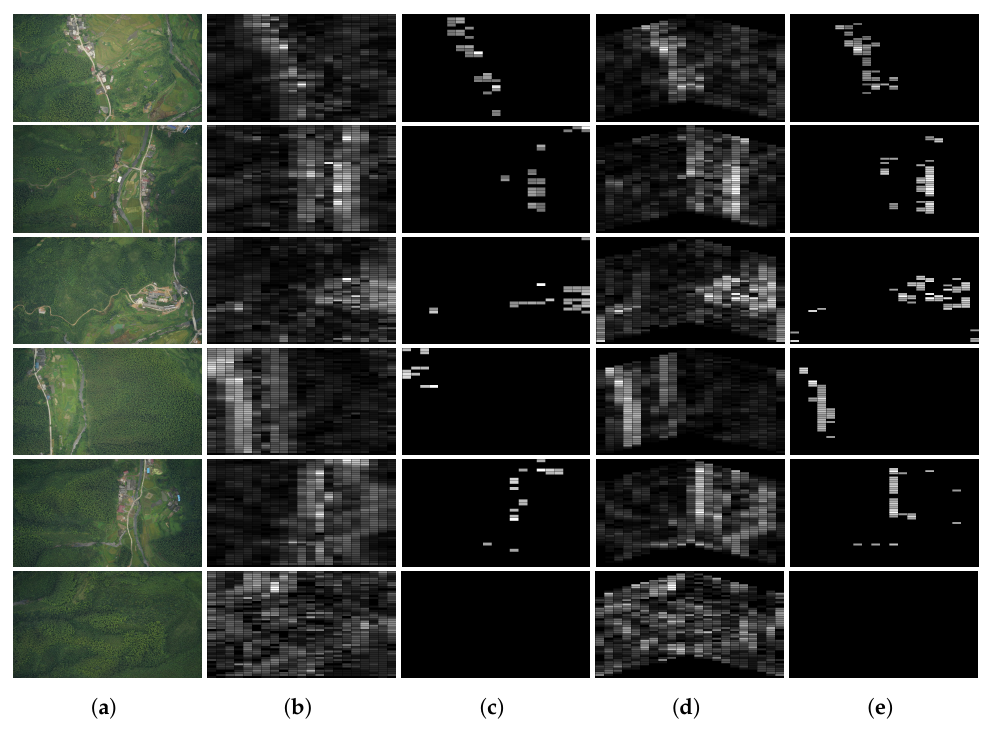
Figure 6. Formation Based Distributed Salient Region Detection. ( a ) Original Scene; ( b ) Line Case; ( c ) σ = 20 (Line); ( d ) V-shape Case; ( e ) σ = 20 (V-shape).